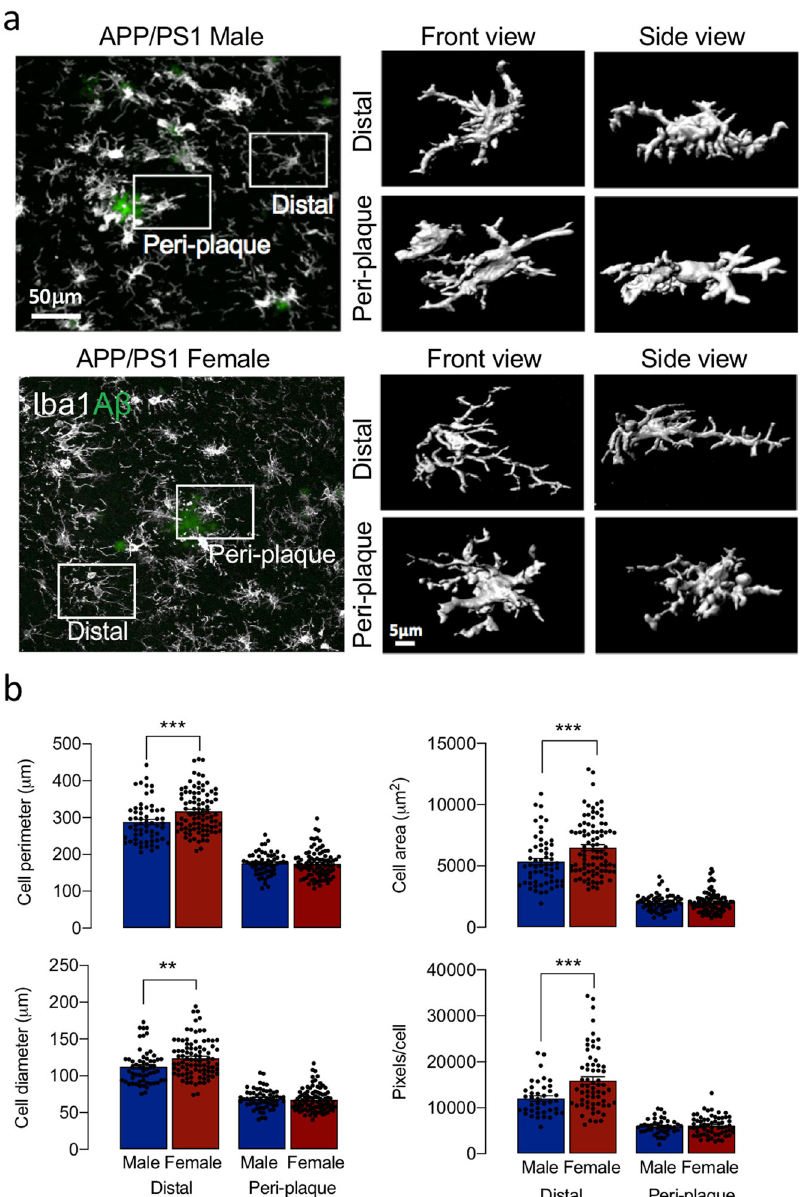
Fig. 3 Evidence of sex-related differences in morphology of microglia distal from plaques. a 3D reconstructions showed differences in morphology in peri-plaque and distal microglia (scale bars = 50 and 5 μ m in the main image and high-magni fi cation image, respectively). b Cell perimeter, area, diameter (59 – 89 cells analysed) and pixels/cell (42 – 63 cells analysed) were markedly reduced in peri-plaque compared with distal microglia and these measures were increased in distal microglia from female, compared with male, mice ( §§§ p < 0.001). Data, expressed as means ± SEM ( n = 5 or 6 mice/group), were analysed by 2-way ANOVA and Tukey ’ s post hoc multiple comparison